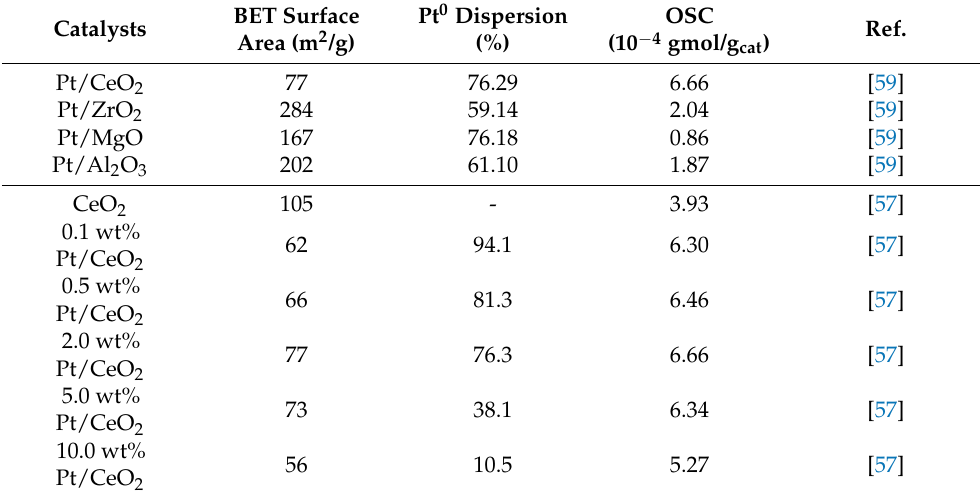
Table 11. Characteristics of Pt-based Catalysts.